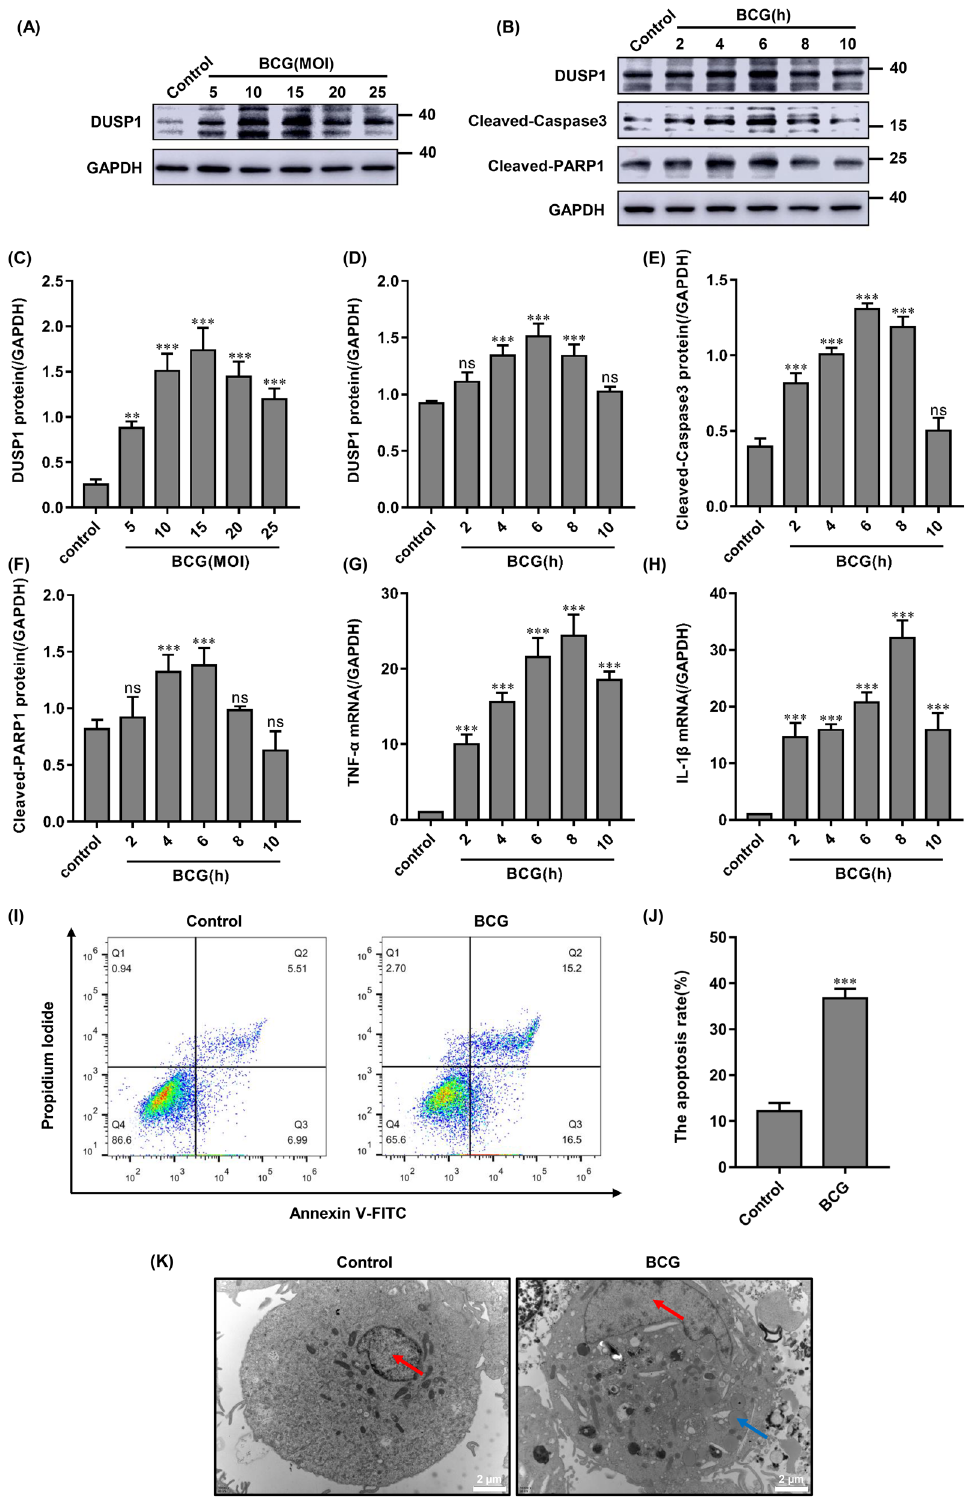
Figure 1. BCG infection induces apoptosis in THP-1 cells and promotes the expression of DUSP1 and pro-inflammatory cytokines. ( A , C ) DUSP1 protein expression detected by Western blotting after 6 h of BCG infection of THP-1 cells at different MOI. ( B , D – F ) DUSP1, Cleaved-Caspase3 and Cleaved-PARP1 protein expression detected by Western blotting after BCG (MOI = 10) infection at different time points. ( G , H ) Gene expression of TNF-α and IL-1β detected by RT-qPCR after different times of BCG infection (MOI = 10). ( I , J ) After BCG infection of THP-1 cells for 6 h, the apoptosis rate was detected by flow cytometry. ( K ) After BCG infection of THP-1 cells for 6 h, the ultrastructure of macrophages was observed by transmission electron microscopy (10,000 ×), the blue arrow denotes the cytoplasmic vacuole of apoptotic cells, while the red arrow indicates the nucleus. Scale bar, 2 μm. All data are represented as mean ± SD (n = 3). (* p < 0.05, ** p < 0.01, *** p <